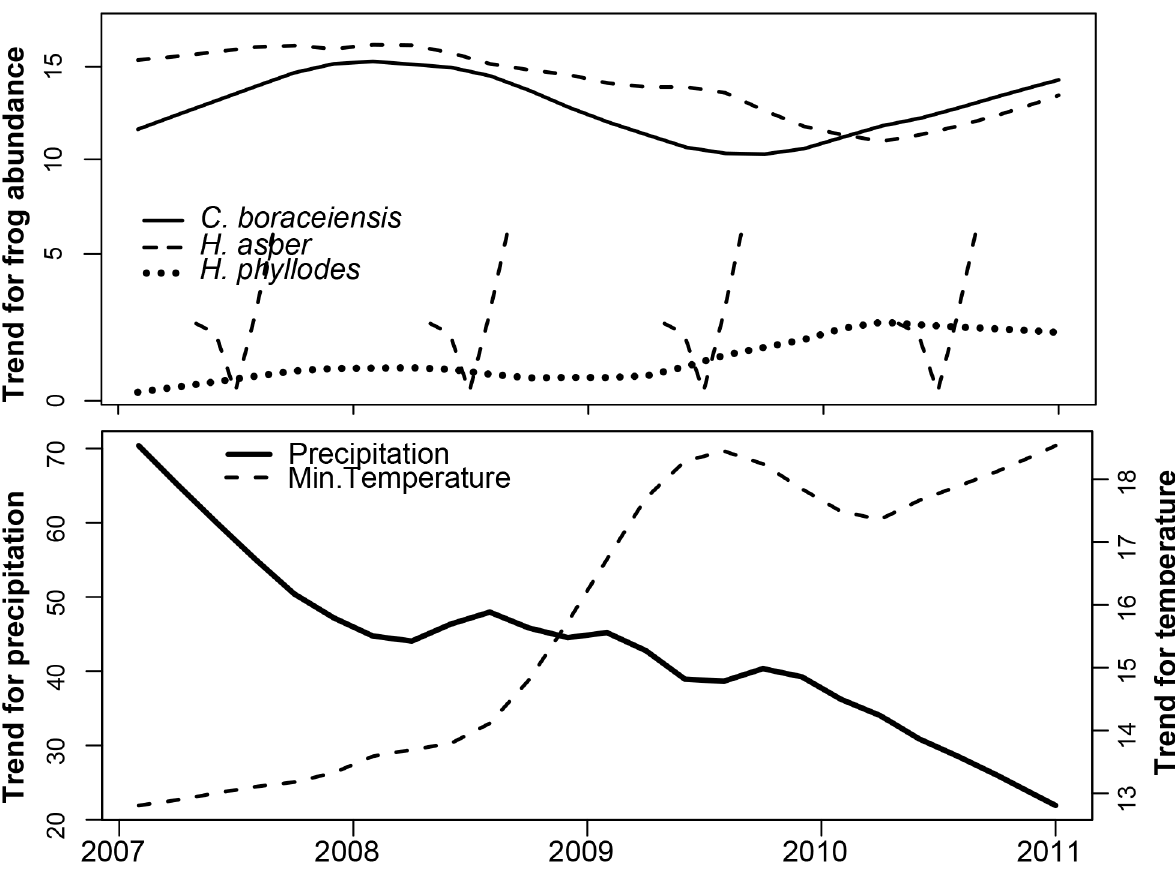
Fig 3. Frog abundance, temperature and precipitation. Trends of the time series data of: (A) the mean number of individuals found in four stream transects, and (B) monthly minimum temperature (°C) and precipitation (mm) at Parque Estadual da Serra do Mar, Brazil.